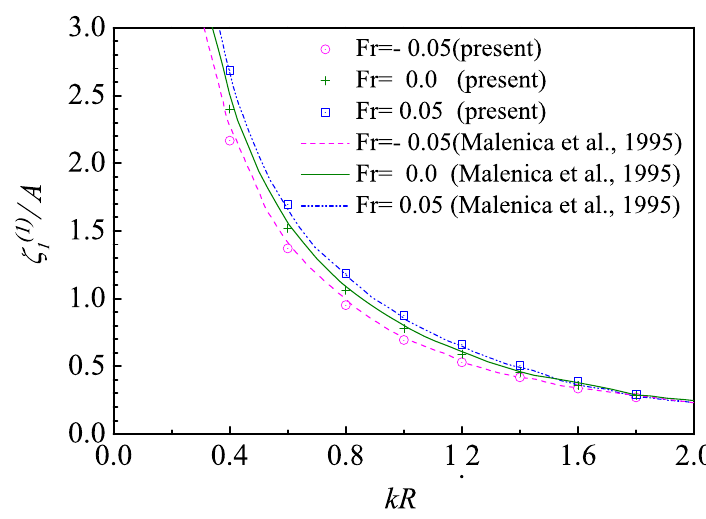
Figure 9. The 1st-order surge motion amplitude of the vertical cylinder at a forward